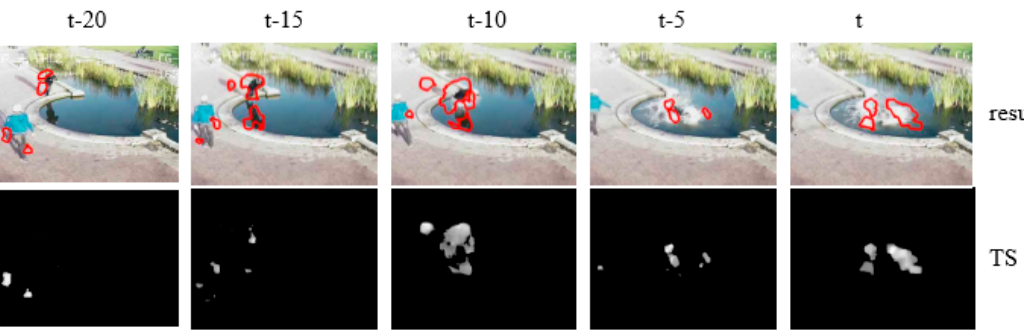
Figure 15. Examples of detection results for abnormality from the No. 8 data.